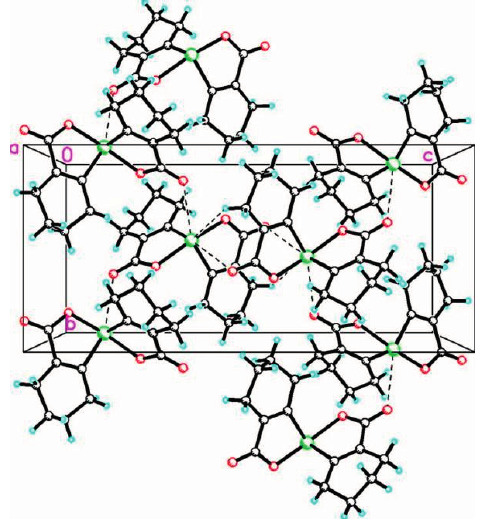
Figure 8. Two-dimensional packing diagram of compound 21 . Selected bond lengths (Å) and bond angles (°); Te···O2A 2.936(35) Å, Te···O2A–C7A